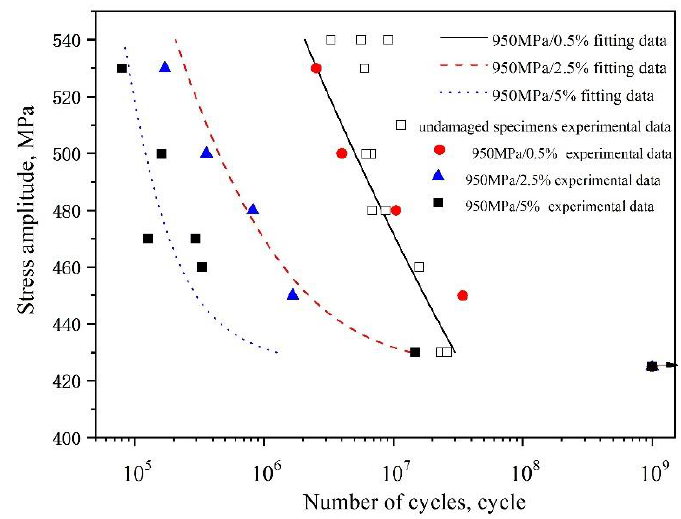
Figure 8. Fatigue life prediction of TC21 titanium alloy after LCF predamage.